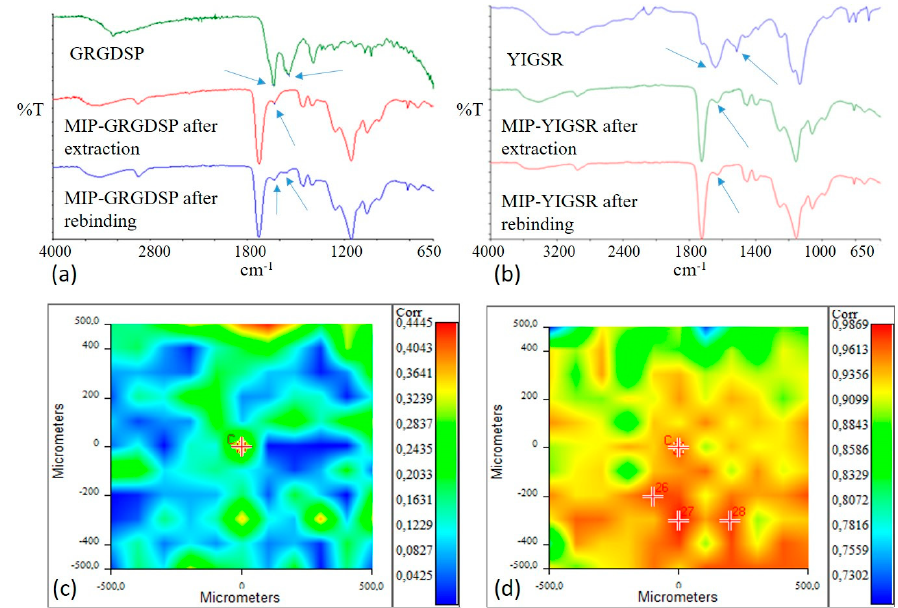
Figure 2. Infrared spectra of: ( a ) GRGDSP peptide, MIP-GRGDSP after extraction, and MIP-GRGDSP after rebinding; ( b ) YIGSR, MIP-YIGSR after extraction, and MIP-YIGSR after rebinding. Amide I and Amide II adsorption bands are indicated by arrows. Correlation maps with YIGSR spectrum for MIP-YIGSR after extraction ( c ) and MIP-YIGSR after rebinding ( d ). Colors in correlation maps correspond to correlation values (from red, higher values, to blue, lower values), as reported in the bars on the right in figures ( c ) and ( d ).